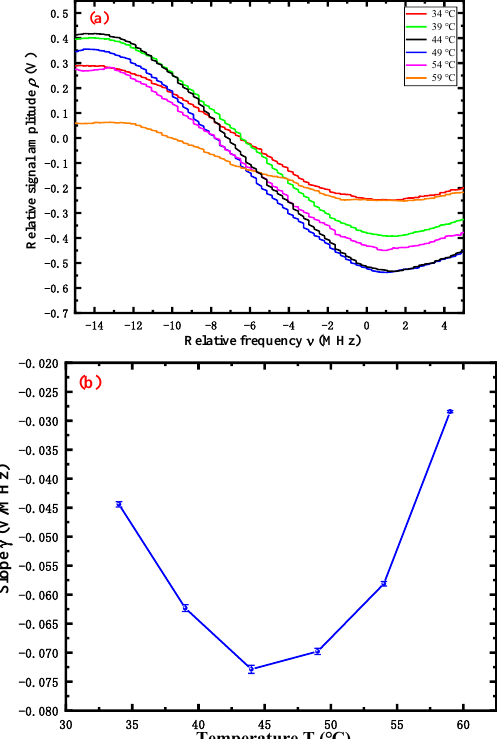
Figure 4. The results of the demodulated dispersive signal and its slope versus temperature of the Rb cell. ( a ): The measurements of the demodulated dispersive signal with varying temperatures T ∈ [34 °C, 59 °C]. ( b ): The blue points represent the slope of the demodulated dispersive signal fringe of the 87 Rb D2 F = 1 → F ′ = 1.